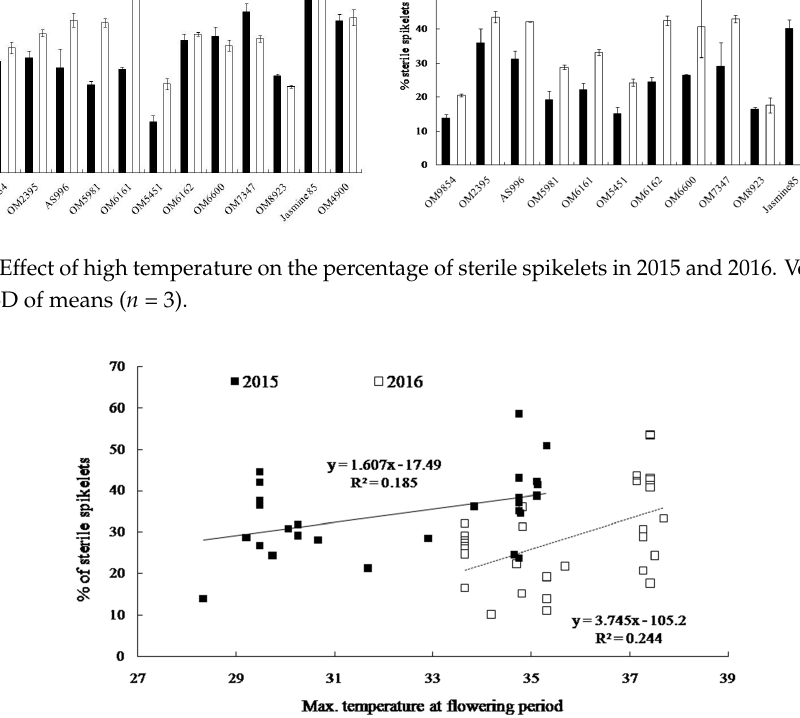
Table 1. Mean yields and yield components of Vietnamese cultivars under control and high